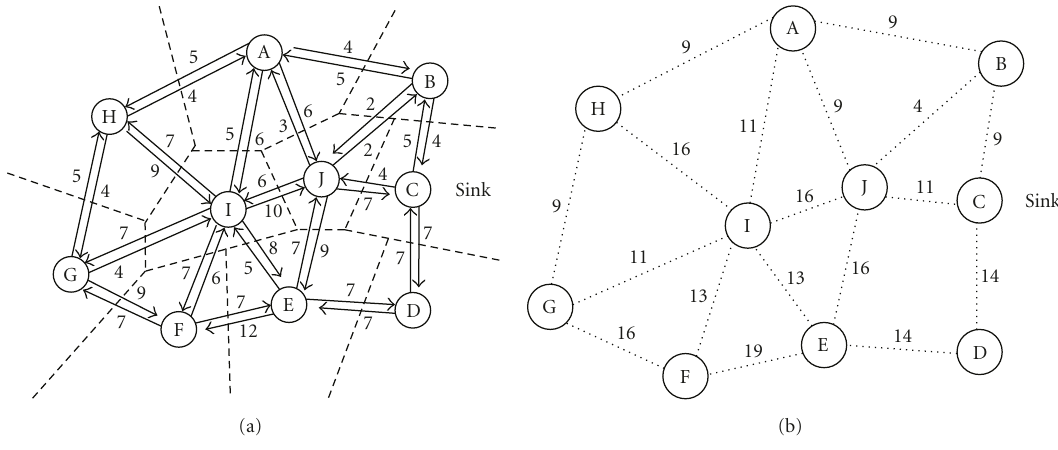
Figure 1: Voronoi Graph and Object Movement